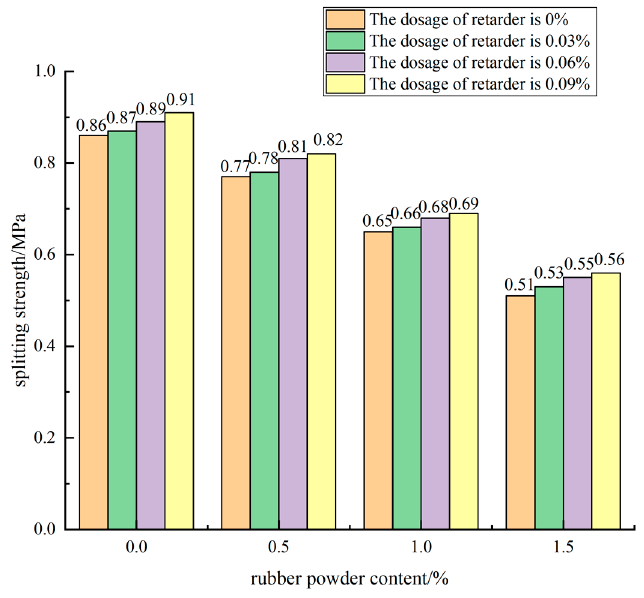
Figure 13. Effect curve of rubber powder content on splitting strength.